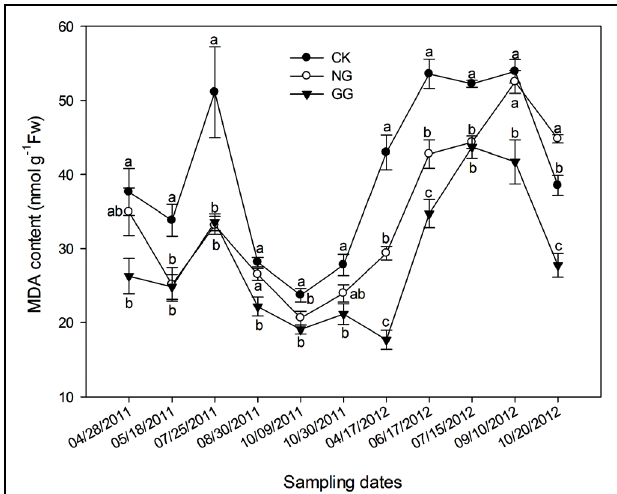
FIGURE 1 | Effect of relay intercropping with normal garlic or green garlic on the malondialdehyde (MDA) content in eggplant leaves. Error bars represent the SE of the mean. The letters a, b, and c indicate significant differences at the p < 0.05 level (ANOVA and LSD); n = 3. CK, eggplant monoculture; NG,eggplant under relay intercropping with normal garlic; GG, eggplant under relay intercropping with green